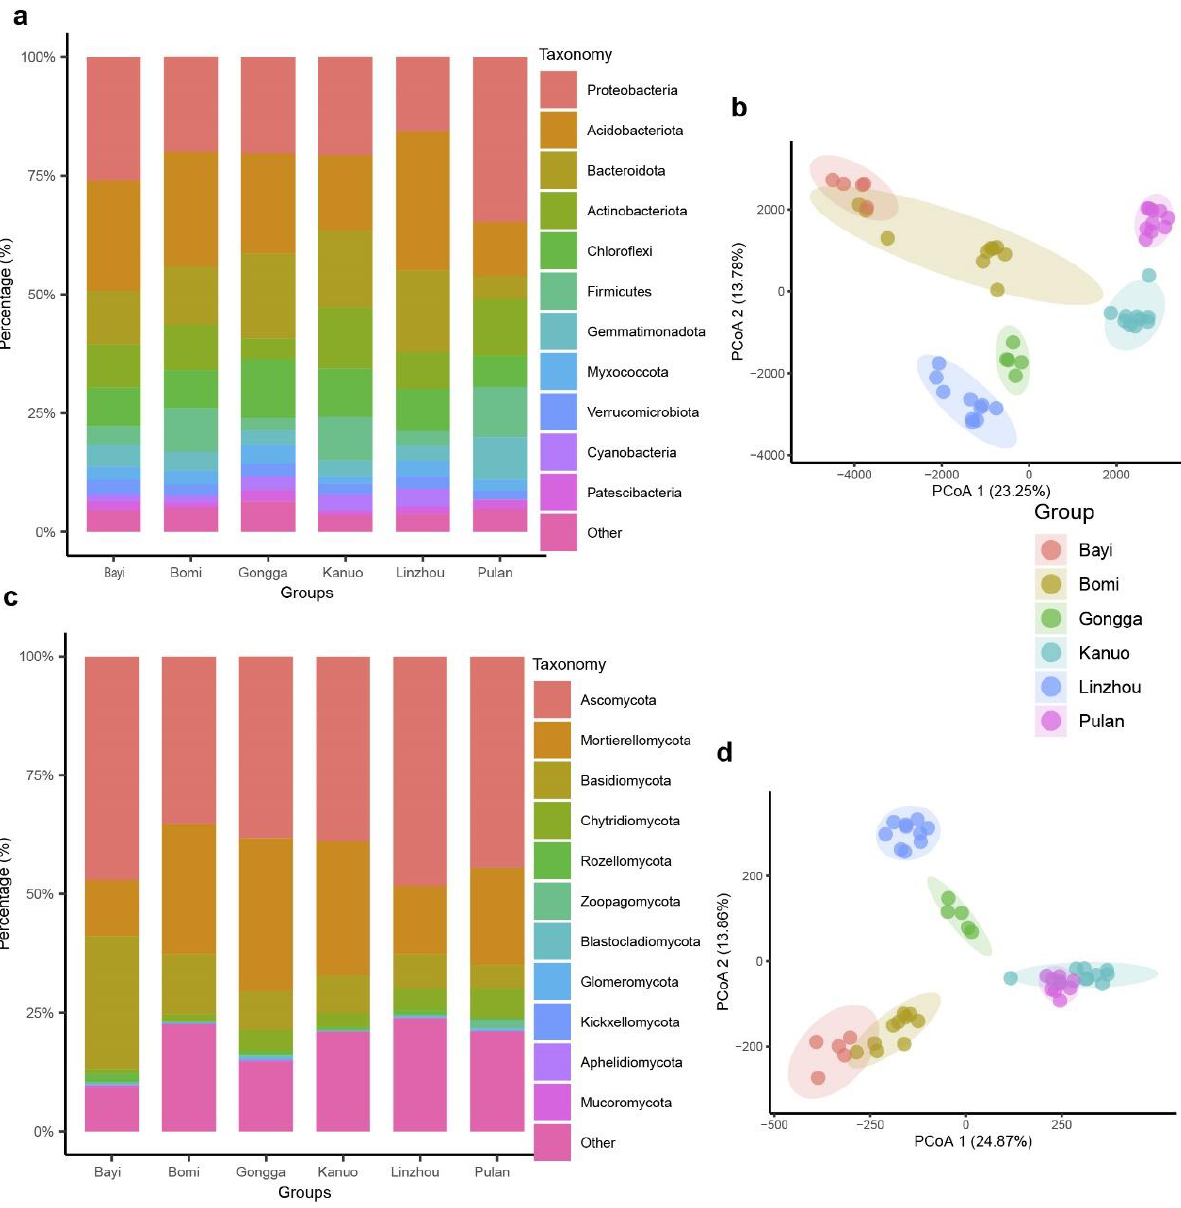
Figure 1. ( a ) Relative abundance of the most dominant bacterial phyla from six different geographical locations, ( b ) the principal coordinate analysis (PCA) of bacterial communities from six different locations showing PCo1 and PCo2, ( c ) relative abundance of the most dominant fungal phyla from six different geographic locations, and ( d ) PCoA of hull-less barley fungal communities from six different locations showing PCo1 and PCo2.